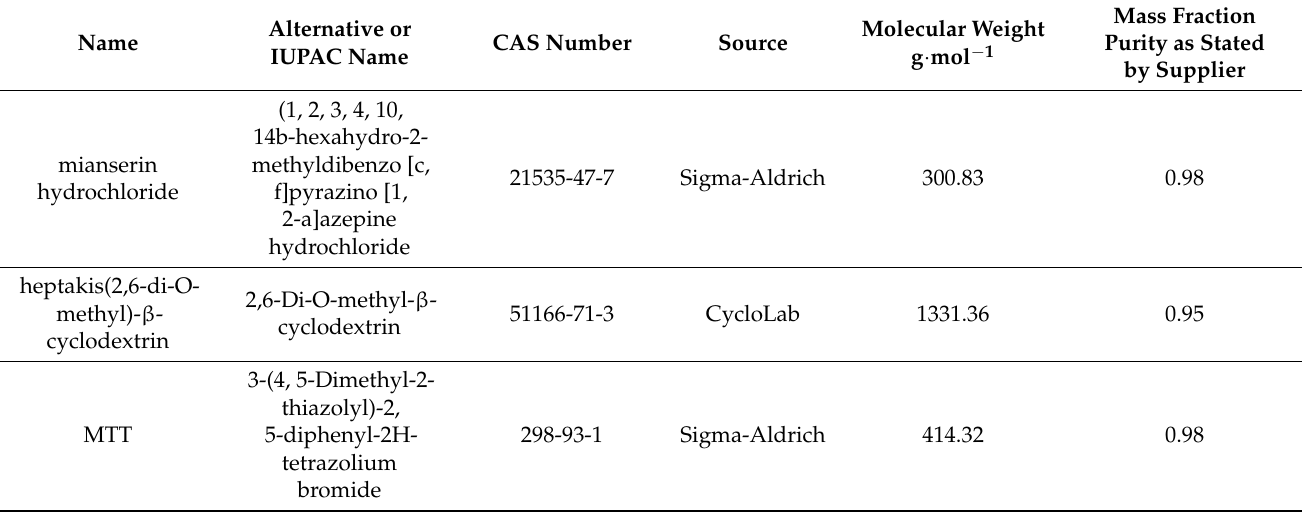
Figure 12. The Chinese hamster cells (B14) viability incubated with mianserin hydrochloride-heptakis (2,6-di-O-methyl)- β -cyclodextrin mixture after 24 h. Error bars represent S.D. *** p < 0.001 versus cells incubated with 200 µ M mianserin hydrochloride solution [10].